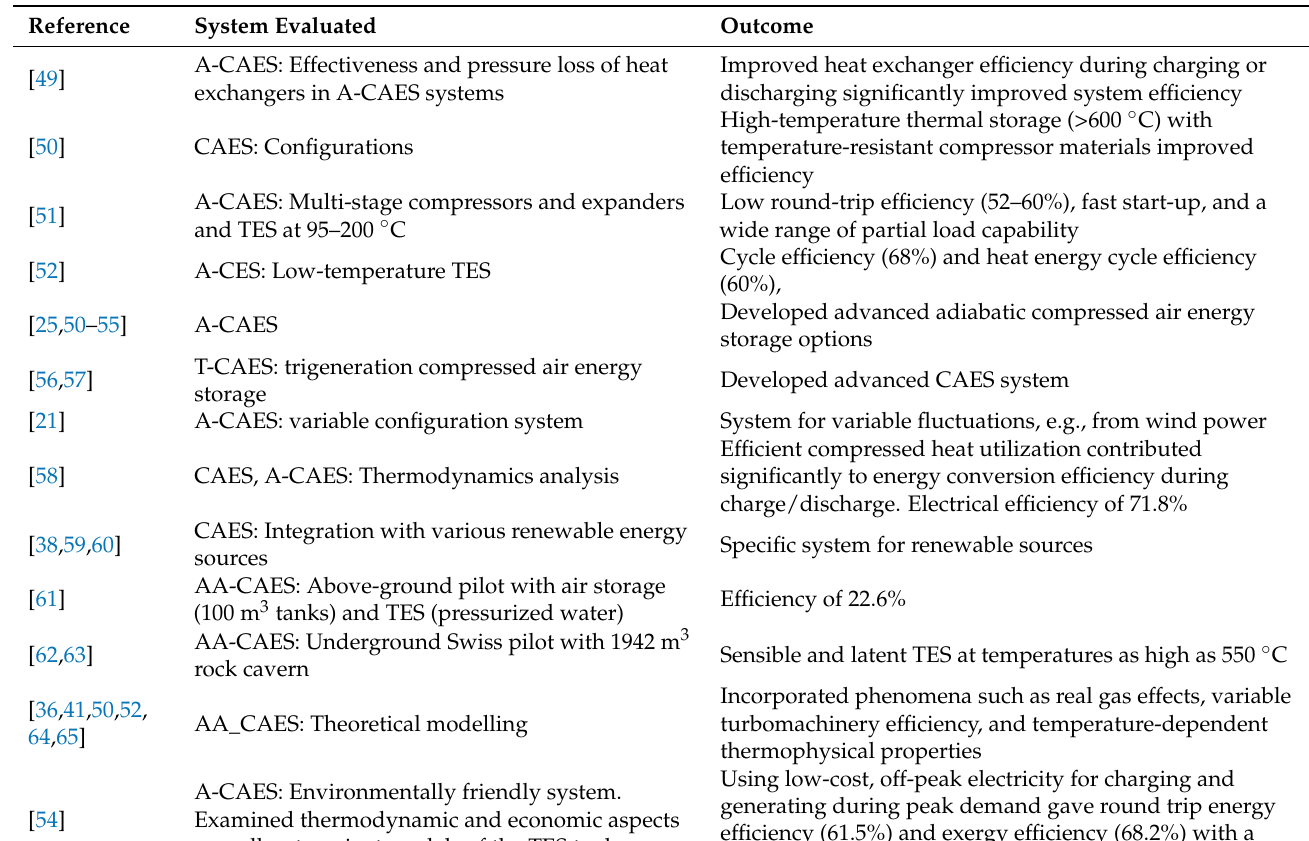
Table 2. Summary of studies and developments of A-CAES